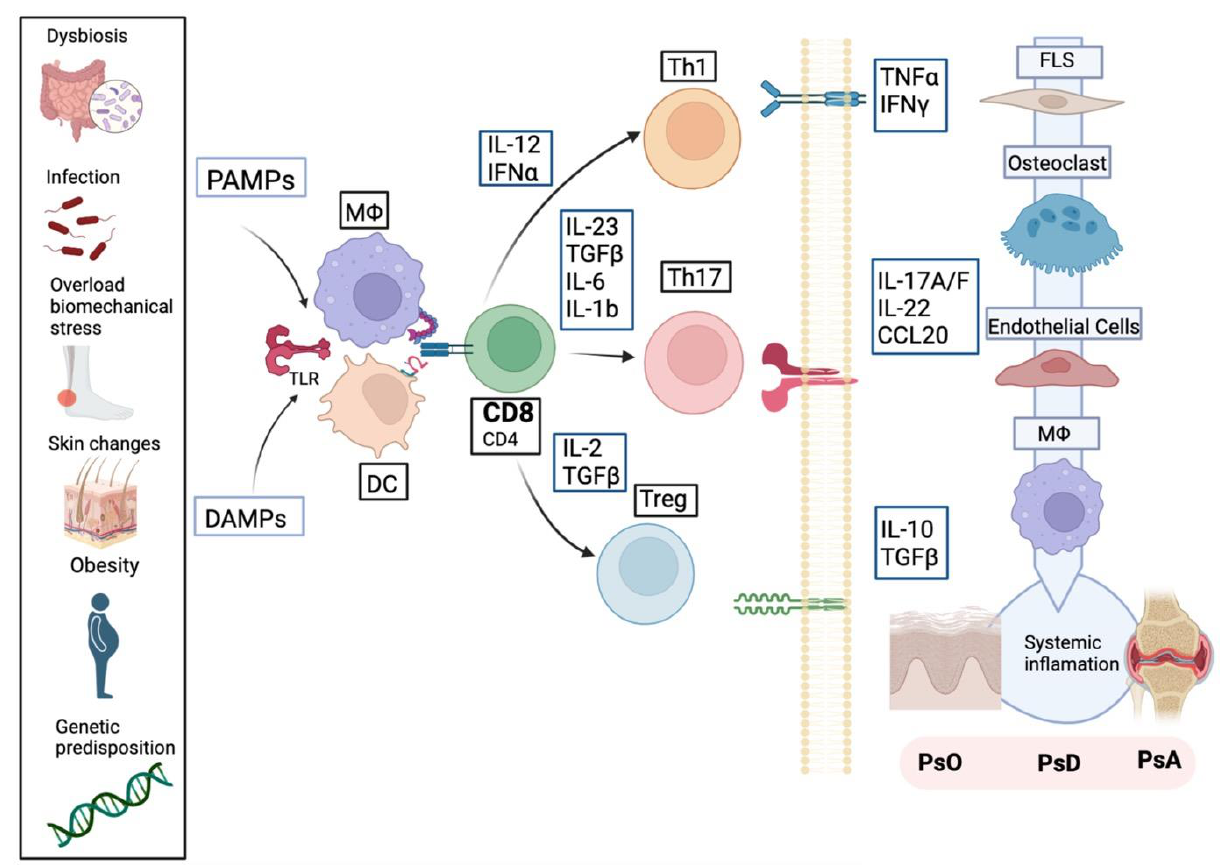
Figure 1. Pathological processes in psoriatic disease (PsD). Predisposing genetic background, infec- tions, obesity, or biomechanical factors act as triggers and precipitate disease onset by activating DC macrophages which present antigens through type major histocompatibility complex (MHC) I to T cells (mainly CD8), through Toll-like receptor (TLR) type 2. This favors the local release of cytokines by triggering the innate and adaptive immune response. IL-12 and IFN α stimulate the Th1 response, which releases TNF α and IFN- γ . IL-23, TGFß, IL-6, and IL-1b activate the Th17 response in the presence of IL23, leading to the release of IL17 (mainly A isoform), IL22, IL26, and CCL20. Moreover, regulating and deactivating the inflammatory cascade requires the response mediated by Treg cells through IL-2 and TGFß. These released cytokines interact with their transmembrane receptors, pro- moting the release of more cytokines and attracting endothelial cells, macrophages, fibroblasts, keratinocytes, dendritic cells, epithelial cells, chondrocytes, osteoclasts, and osteoblasts. Activation of the immune system leads to synovitis, enthesitis, erosions, and lesions in the articular cartilage and skin. DAMPS (Damage-associated molecular pattern), PAMPs (Pathogen-associated molecular patterns), DC (dendritic cells), MΦ (Macrophages), CD8 (CD8 T lymphocyte), CD4 (CD4 T lympho- cyte), Th1 (T helper 1 cells), Th17 (T helper 17 cells), Treg (T regulatory), FLS (synovial fibroblast).